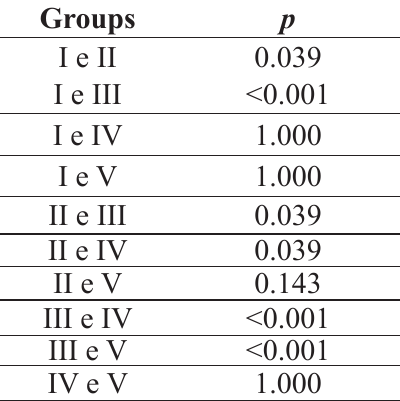
Significance: p≤0.05 (z